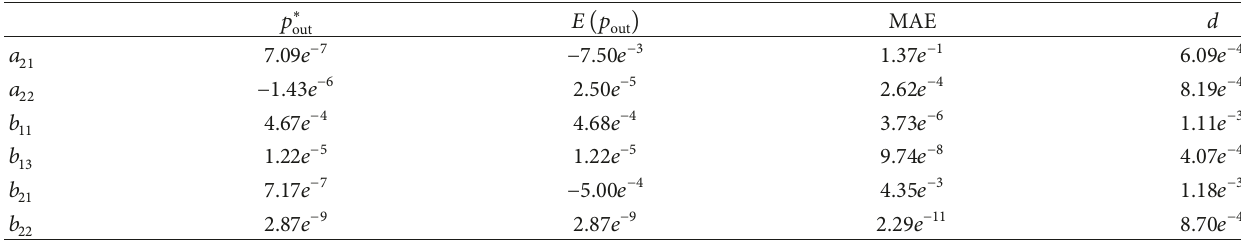
Table 4: ARX to SS transformation